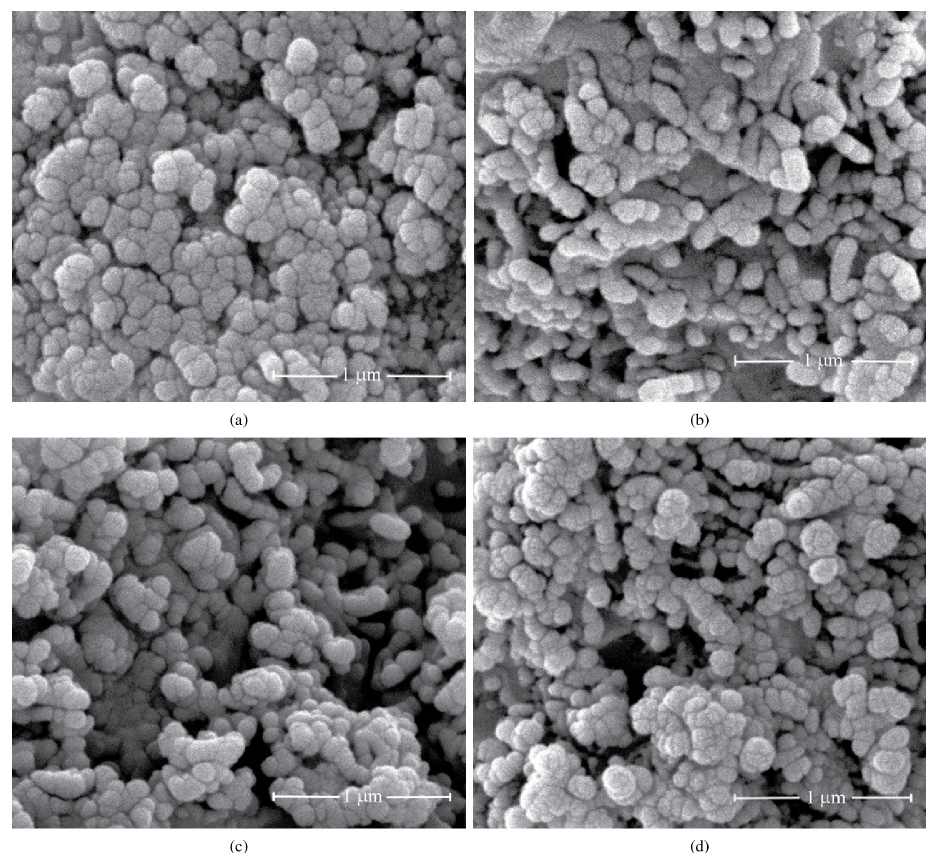
Figure 6. SEM micrographs of samples: (a) G1, (b) G2, (c) G3 and (d)